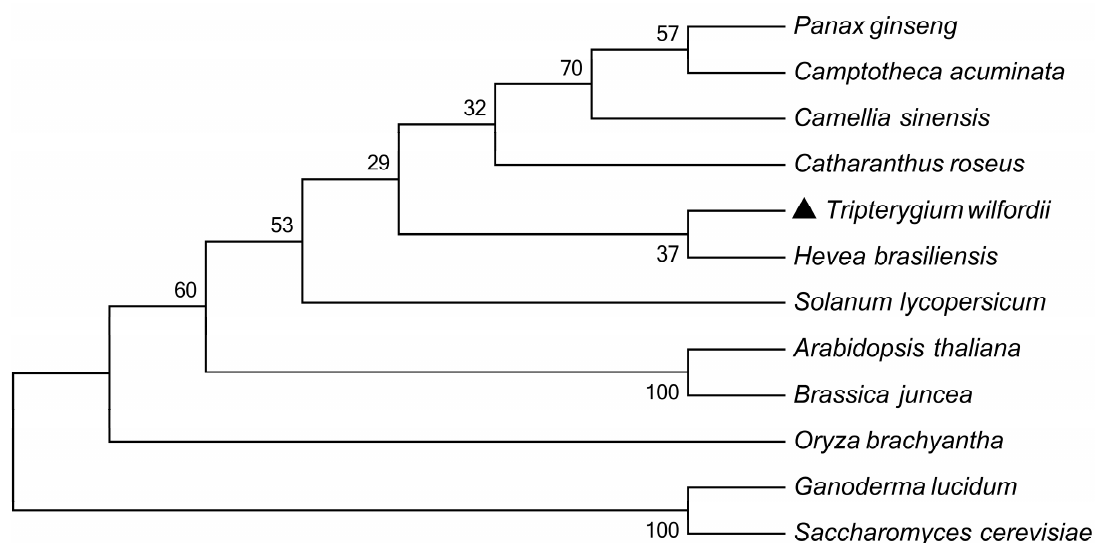
Figure 2. Phylogenetic tree of HMGS from different species using the neighbour-joining method.